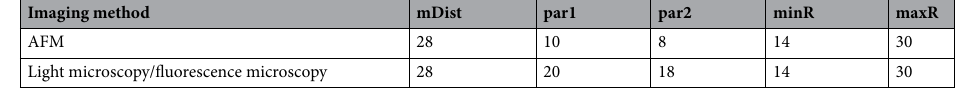
Table 4. Set of values used for the Hough gradient method with the respective microscopy technique.